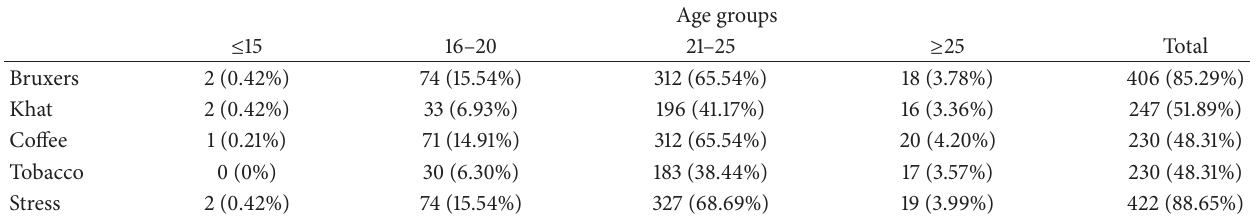
Table 2: Prevalence of bruxism and the use of potential risk factors among different age groups.